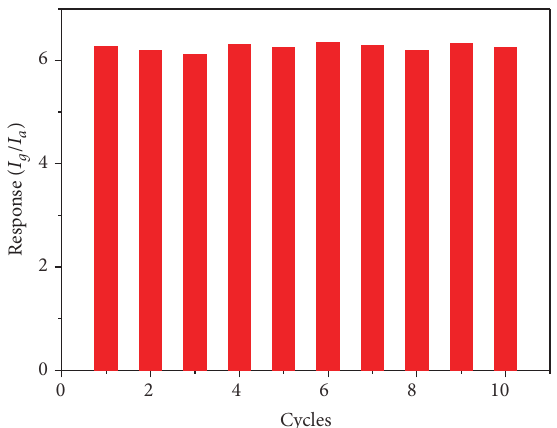
Figure 6: Response curves of the mesoporous SnO 2 nanowires to 100ppm of ethanol after 10 cycles of gas on and off at 250 ∘ C.